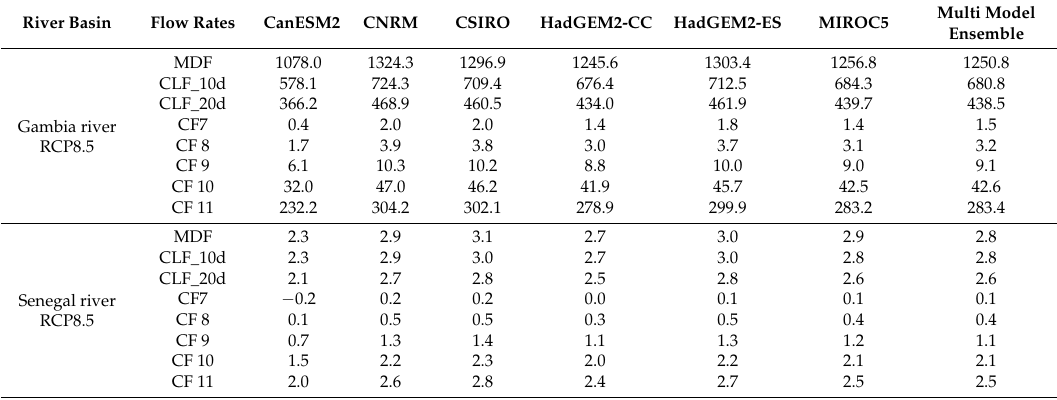
Table A4. Relative change in flows below the median for different chosen GCM under RCP8.5. River